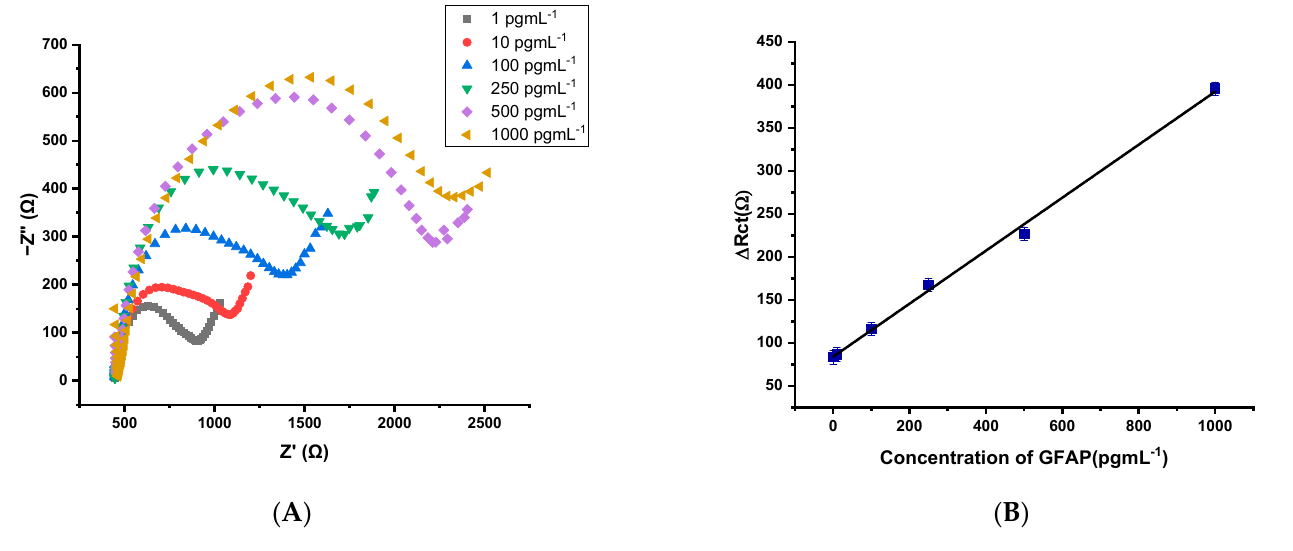
Figure 8. Application of the developed GFAP biosensors with the EIS results, ( A ) and the calibration curve ( B ) in the synthetic serum sample .